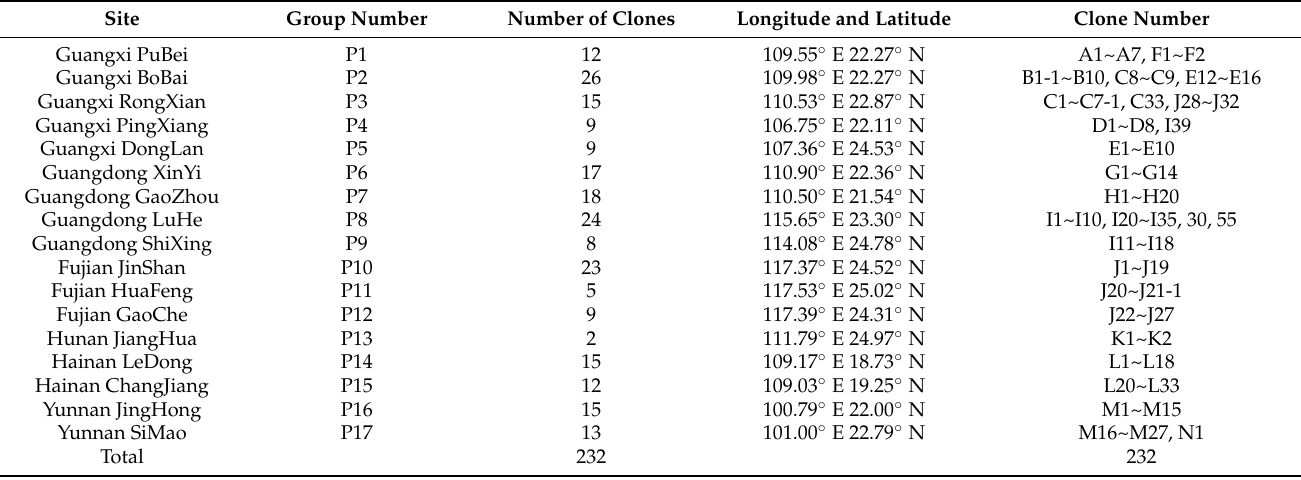
Table 1. Details of sampling points in the 17 province areas of C. hystrix